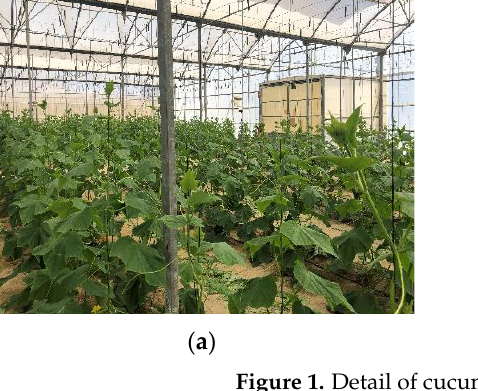
Figure 1. Detail of cucumber crop ( a ) and distribution of the evaluation plots in each experimental sector ( b ).